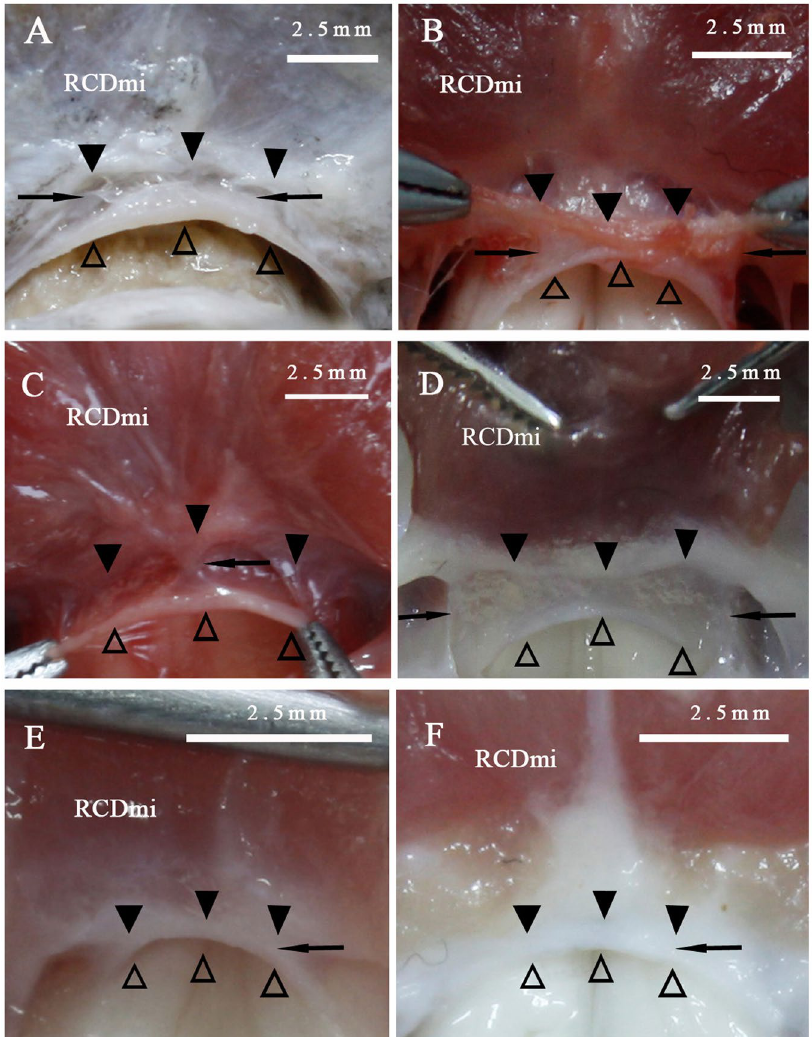
Figure 4. The connections between the PAO membrane and the spinal dura mater (antero-superior view). The PAO membrane and the spinal dura mater were sectioned transversally and simultaneously in Macacamulatta ( A ), Oryctolaguscuniculus ( B ), Canisfamiliaris ( C ), Feliscatus ( D ), Ratusnorvegicus ( E ), Caviaporcellus ( F ). The PAO membrane ( ▲ ) and the spinal dura mater ( △ ) were found tightly connected by some dense connective tissues ( → ) in the dorsal central part of the posterior atlanto-occipital interspace. RCDmi: the rectus capitis dorsal